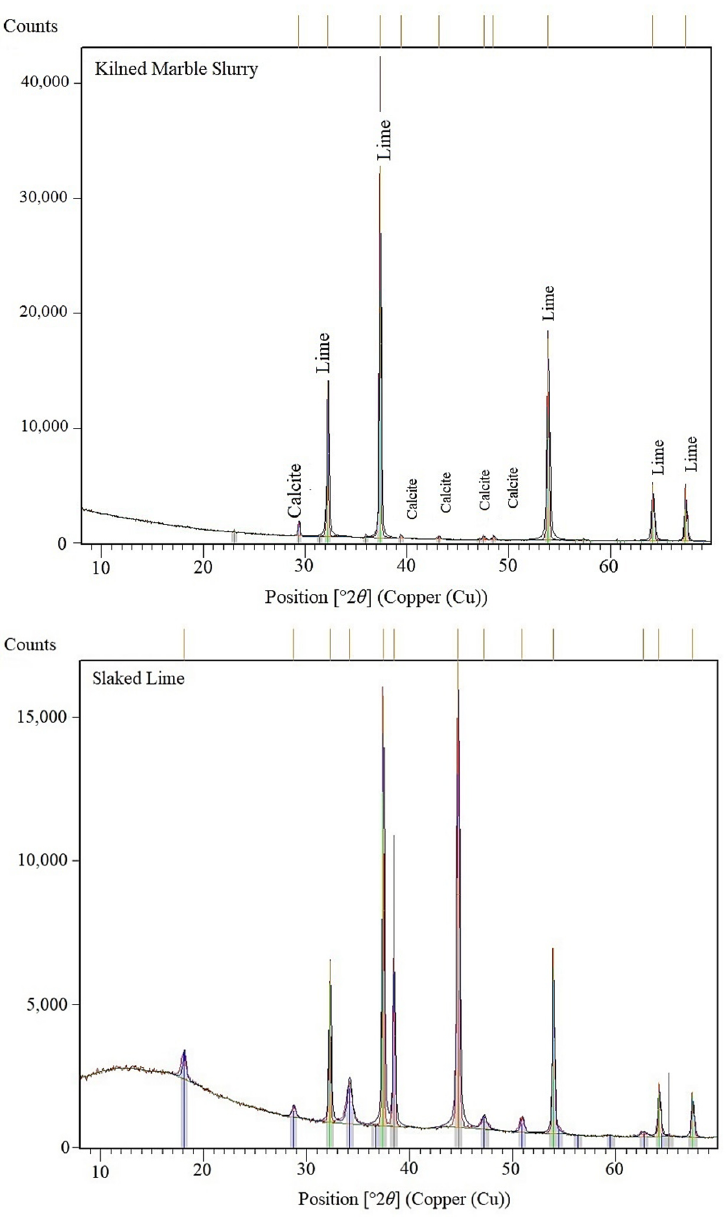
Figure 6. X-Ray diffractograms of kilned marble slurry ( above ) and slaked lime ( below ). As expected, XRD patterns highlight the conversion of marble slurry to lime and portlandite after kiln heating and slaking, respectively. STA performed on slaked lime (Figure 7) indicates that after 10 days an almost complete conversion of Calcium Oxide to Calcium Hydroxide occurred. Figure 7. Simultaneous Thermal Analysis (STA) on slaked lime.